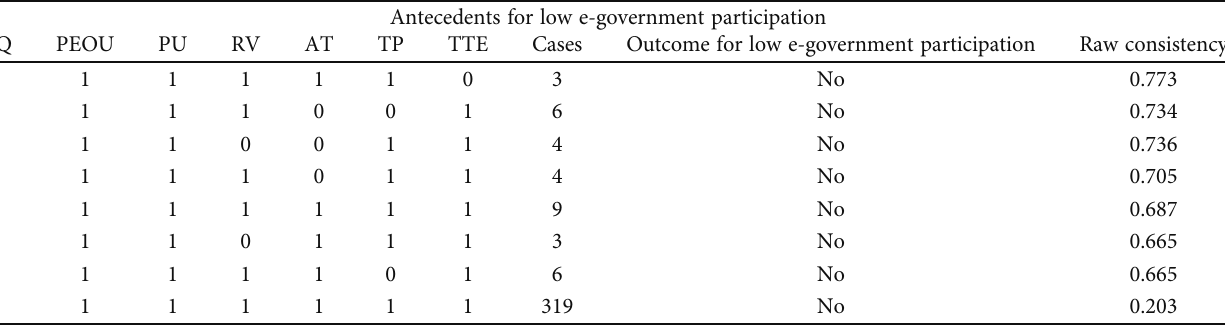
Table 9: Truth table for low e-government participation.